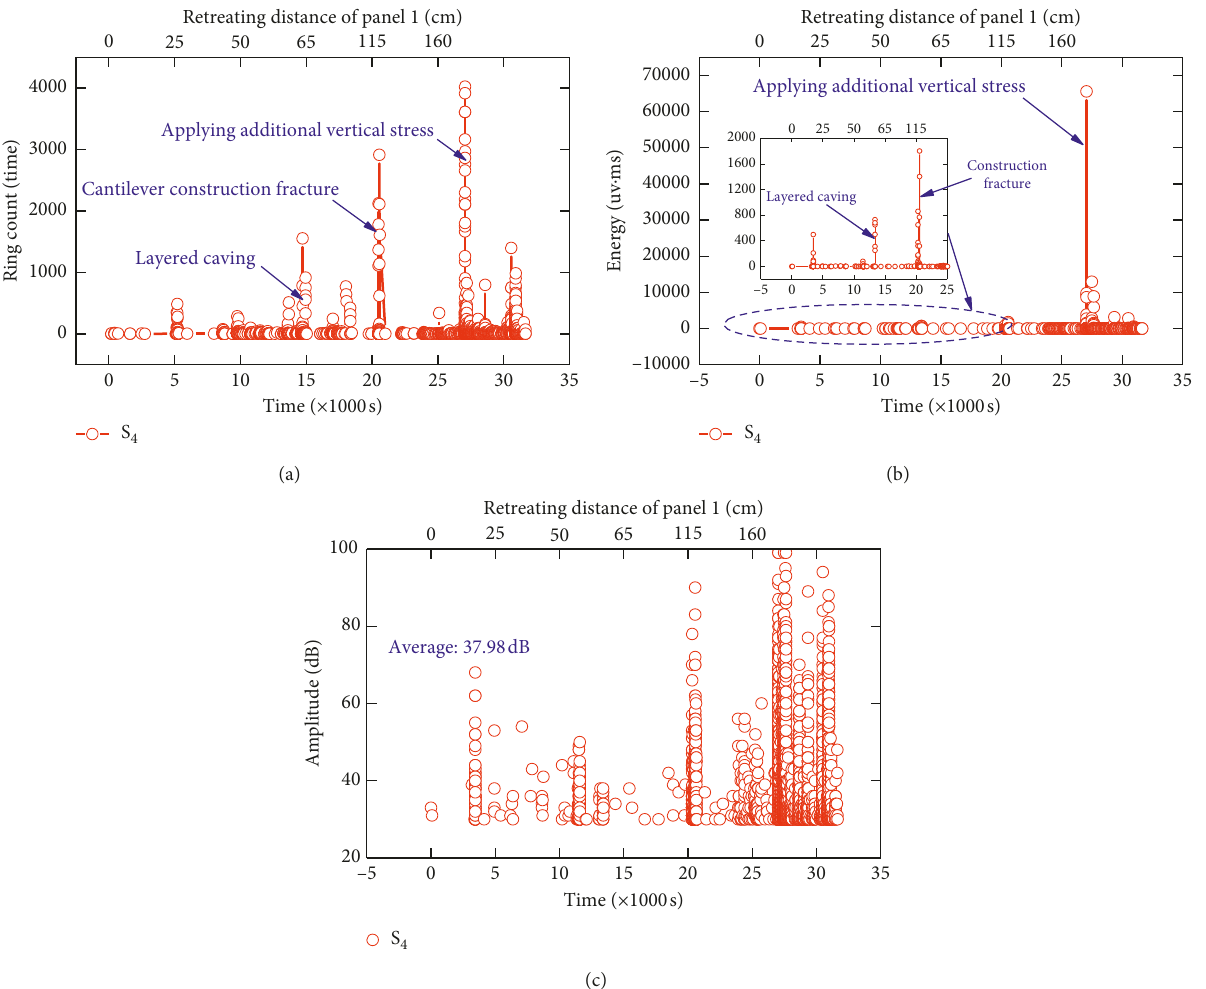
Figure 8: Acoustic emission signals during the activation of the hard roof above the gob. (a) Ring count in measuring point S in measuring point S 4 . (c) Amplitude in measuring point S 4 .